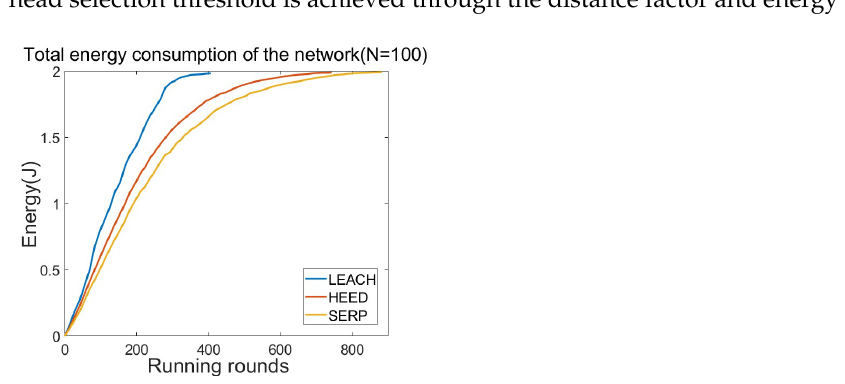
Figure 5. Total energy consumption of the network when the number of nodes N =